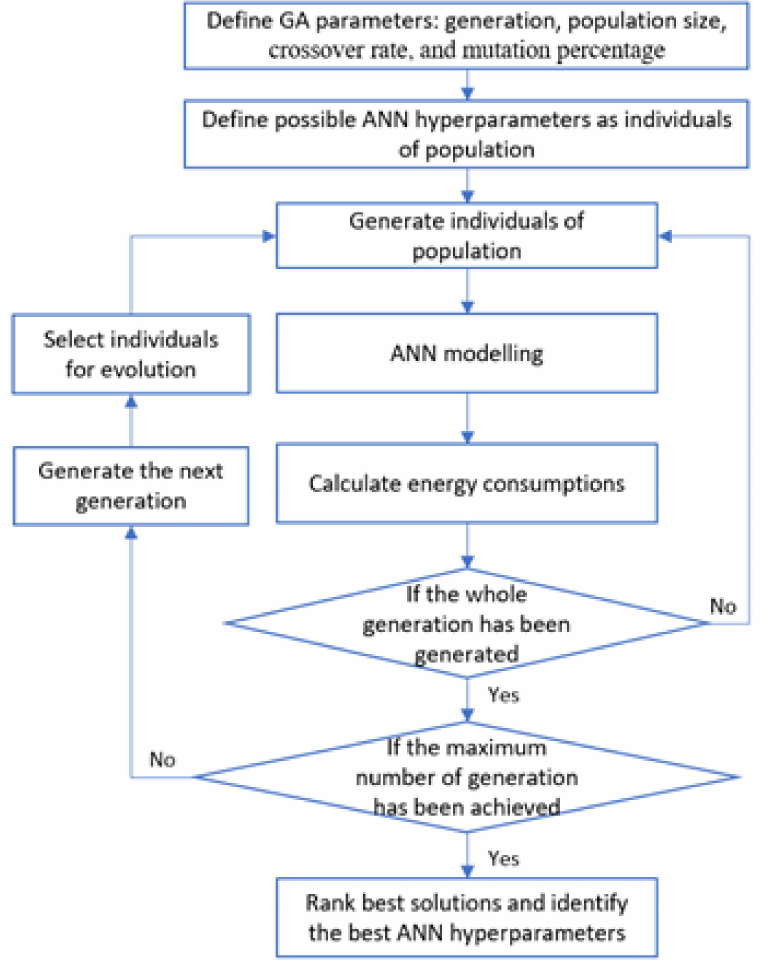
Figure 3. The implementation of ANN-GA model. Table 1. ANN hyperparameters and GA